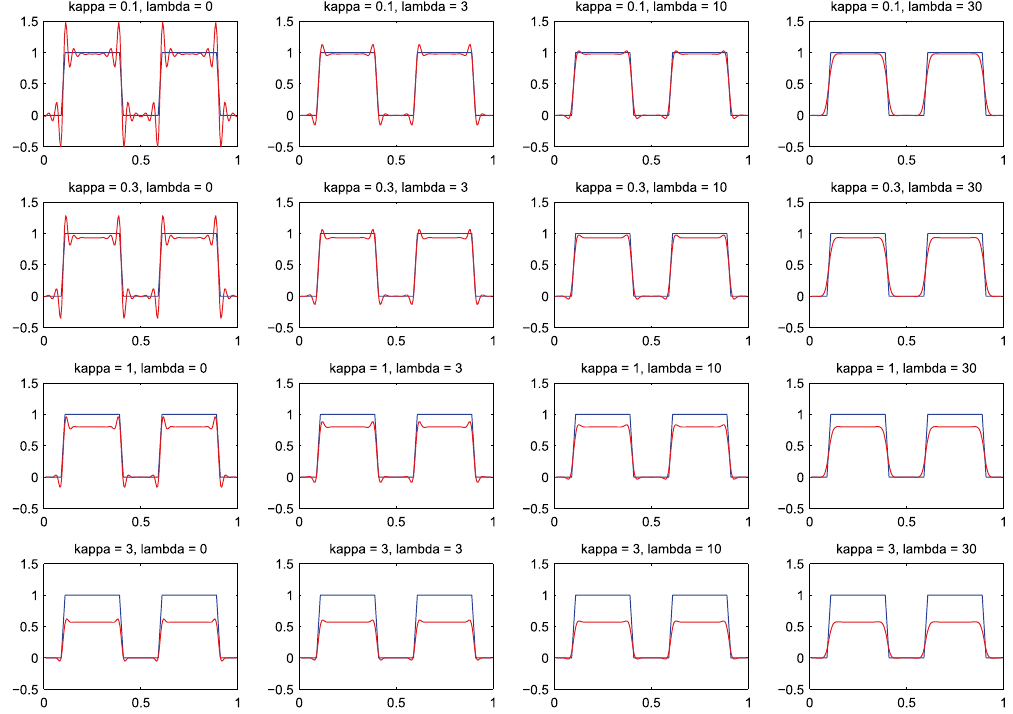
Figure 3. Fourfold super-resolution of a simulated step wave for several combinations of κ , the ridge parameter and (cid:31) , the smoothness parameter. The blue curve is the true input signal and the red curve its